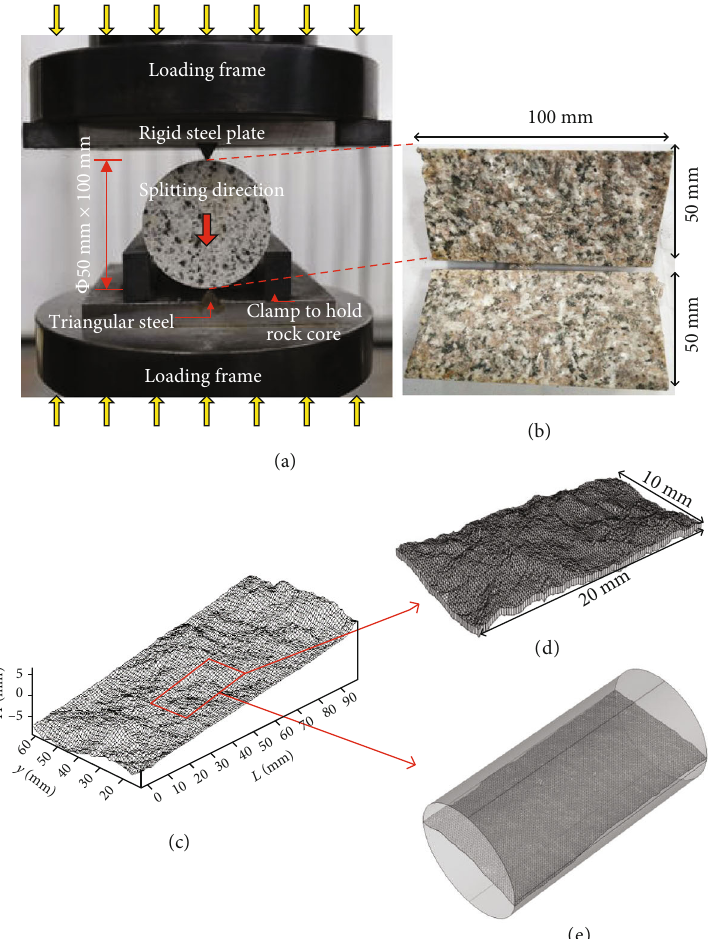
Figure 1: Establishment of the numerical simulation model. (a) Splitting device. (b) Fracture surface. (c) Scanned fracture surface. (d) Fracture model without matrix. (e) Fracture model with